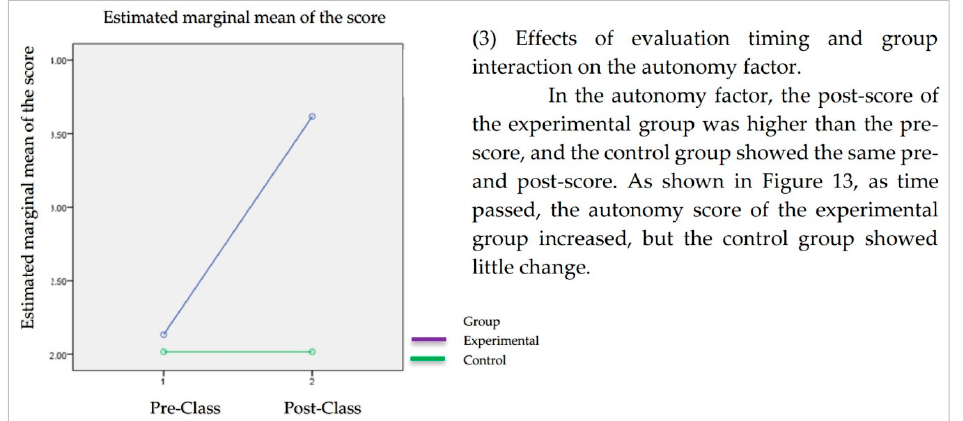
22 of 26 Figure 9. Effect of timing and group interaction on Joint Decision-Making.